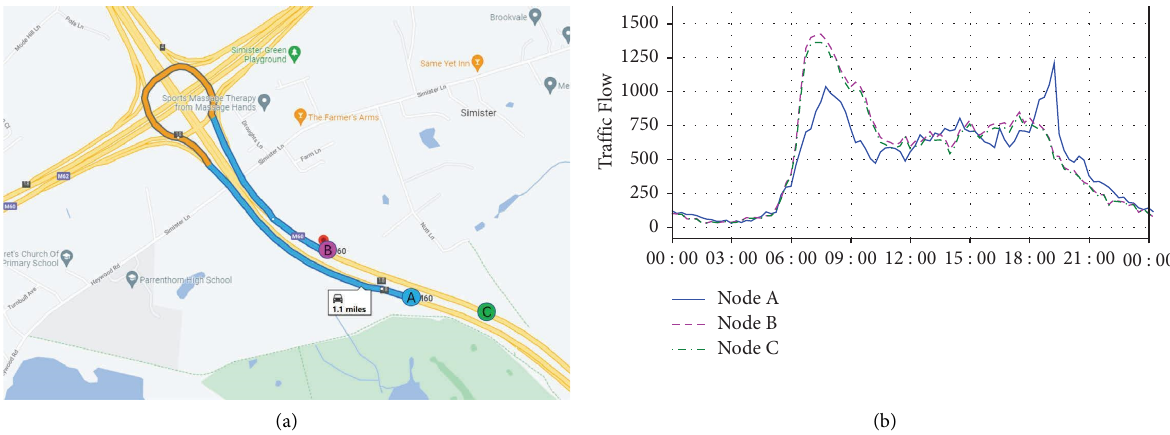
Figure 1: Nonlinear relationship between spatial dependence and Euclidean distance: (a) location distribution of nodes in the trafc network; (b) trafc curve of diferent nodes in a